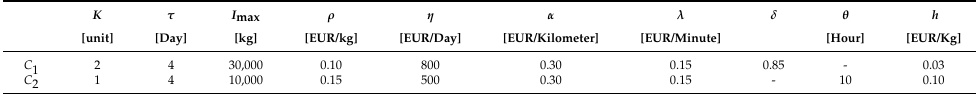
Table 4. Case study: Relevant